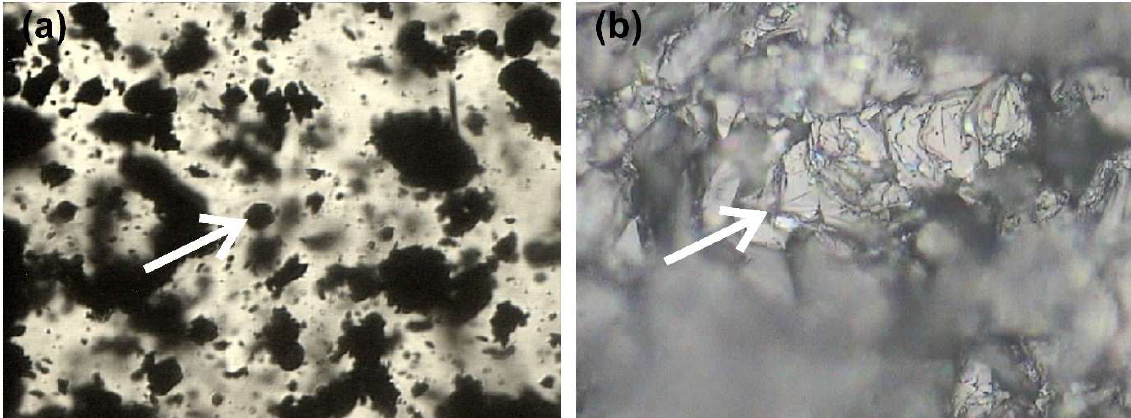
Figure 4. Microscopic images of unburned carbon after graphitization in temperature 3000 ◦ C: ( a ) in the centre, a regular graphite hexagon, transmitted light, parallel polarizers, magn. 400 ×; ( b ) graphite packages, reflected light, parallel polarizers, magn. 400 × ; the arrow points to the morphological form being described.